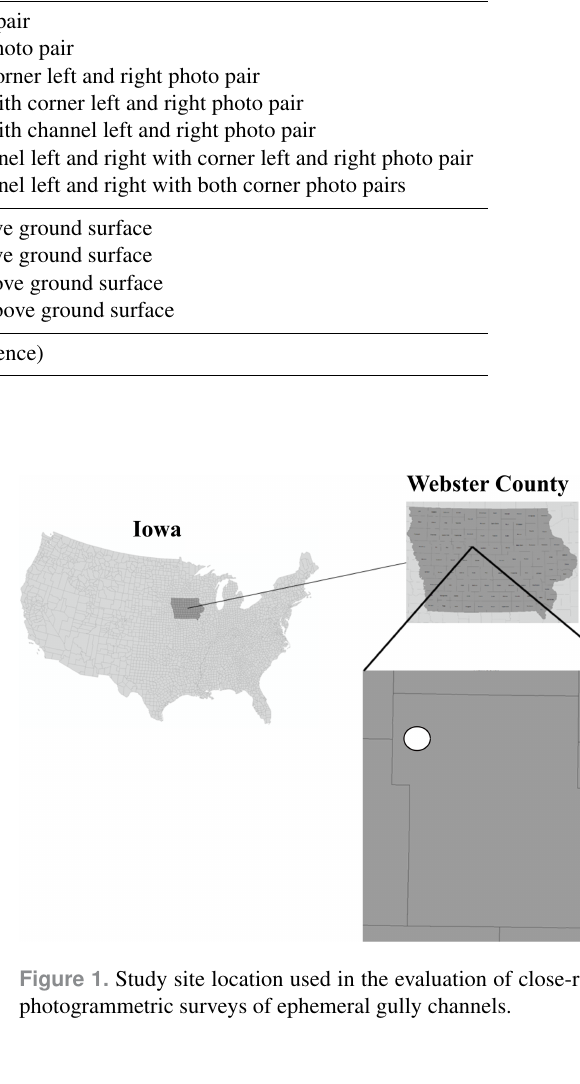
Table 1. Datasets generated by three distinct surveying methods for the purpose of quantifying locational uncertainty in gully studies. Dataset identification